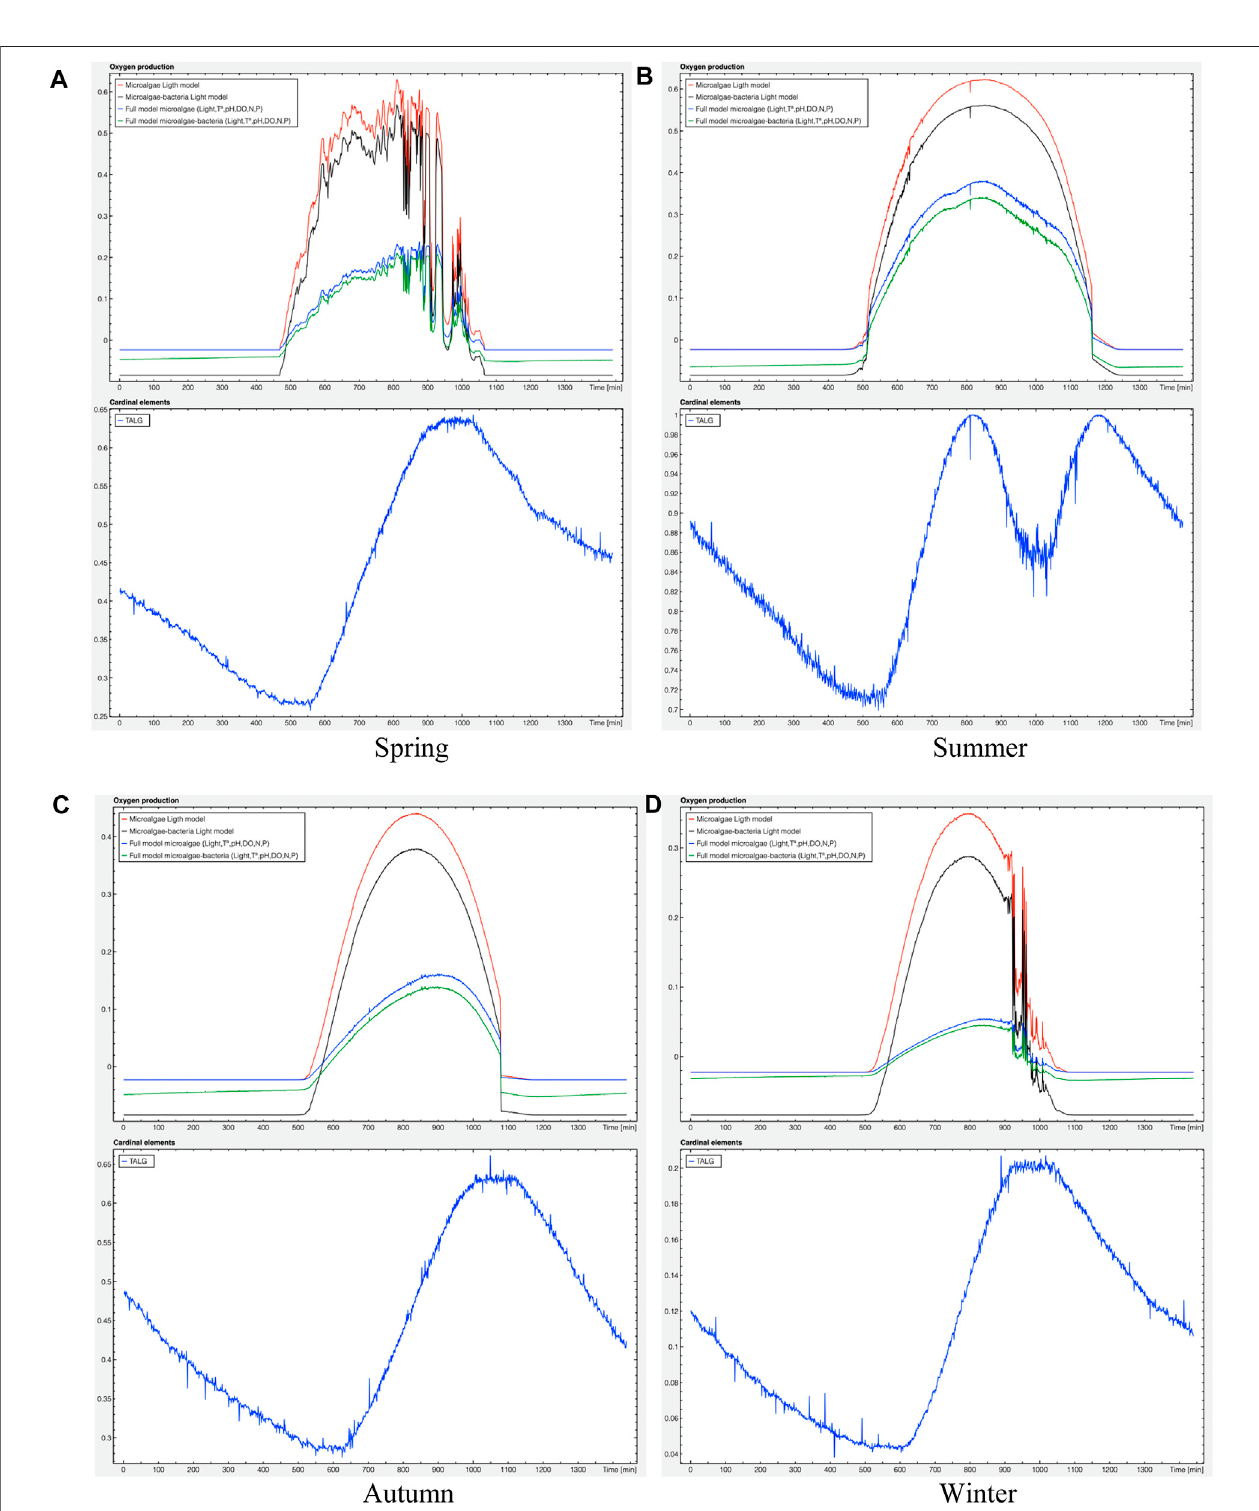
FIGURE 8 | Oxygen production by Dunaliella tertiolecta during the seasons of the year using the proposed biological models, along with the temperature effect using its temperature speci fi c parameters: spring (Panel 8A ) summer (Panel 8B ), autunm (Panel 8C ), winter (Panel 8D ).